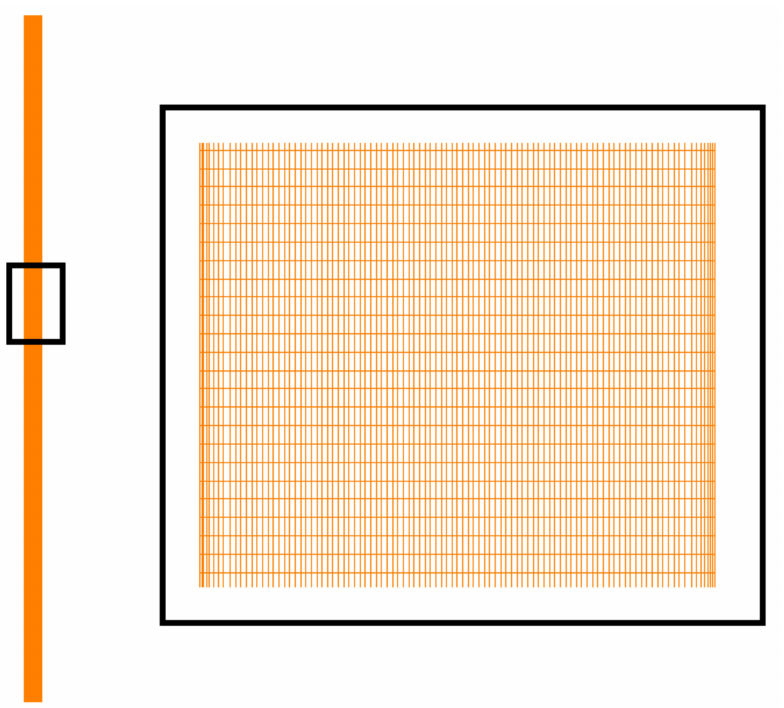
Figure 4. Mesh with 110,000 computing cells for CFD study of oil in TPCT. The boiling process in the TPCT, for filling ratios of 50, 70 and 90%, are shown in Figures 5–7, respectively. At the start of the process, the liquid pool at the bottom of the TPCT is heated; when the temperature of the pool reaches to saturation temperature, the liquid to vapor phase change occurs. The vapor is transferred to the condenser section,